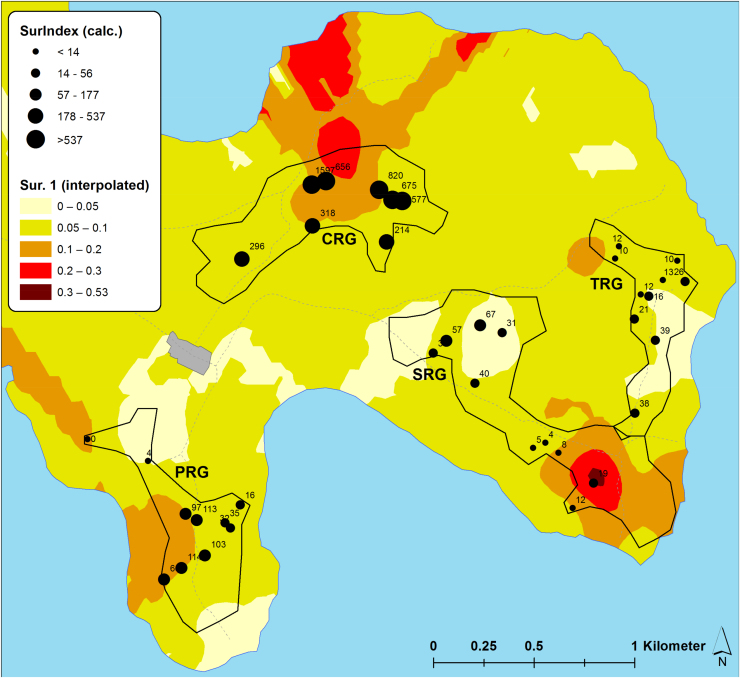
Surrounding CBSD values for PRG, SRG, TRG and CRG fields of Chato, north-western Tanzania, plotted over an interpolated spatial plot of Sur 1.